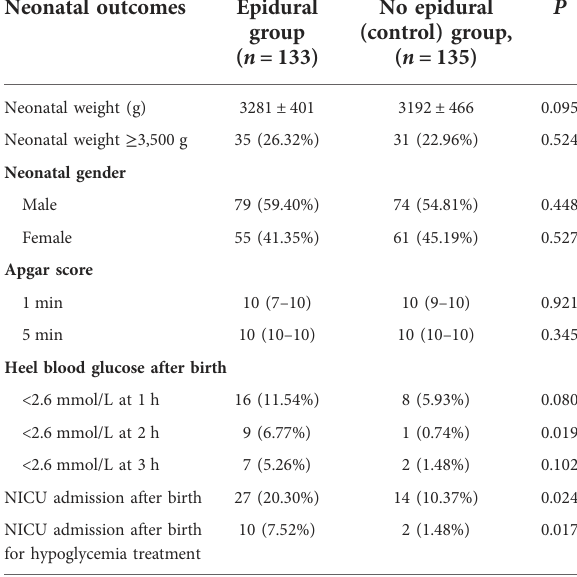
TABLE 3 Health outcomes for newborns of parturients enrolled in this